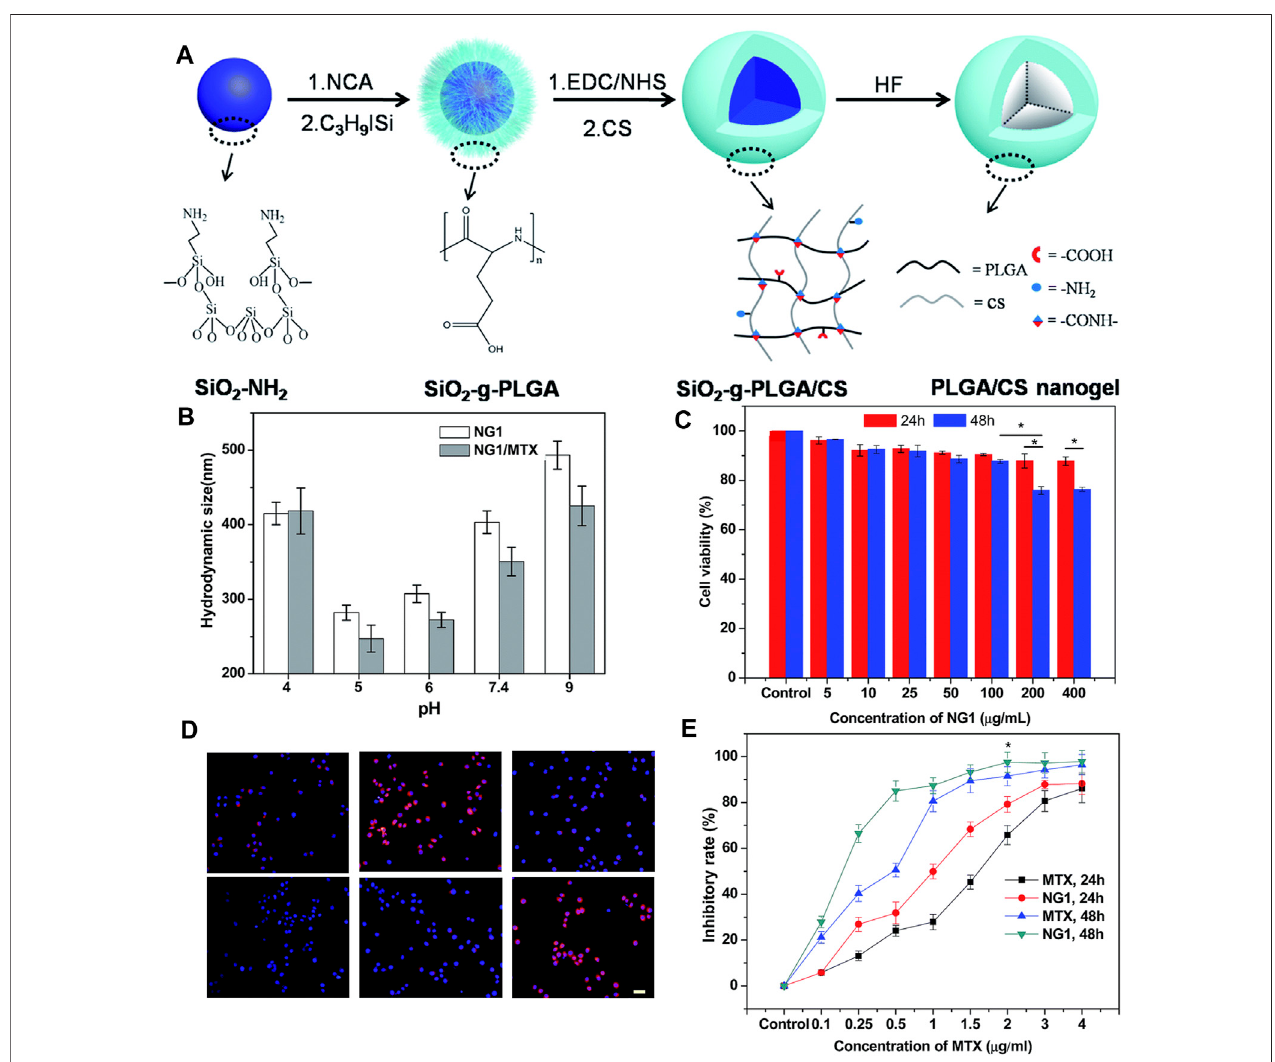
FIGURE2| PhysicalpropertiesofPLGA/CSand theaction ofdrugs(Yanetal.,2017). (A) Synthesismethodofnanogels. (B) Changeinparticle sizeofnanogelsat different pH. (C) Endocytosis effect of nanogels. (D) Inhibition rate of MTX-loaded nanogel and MTX on tumor cells.